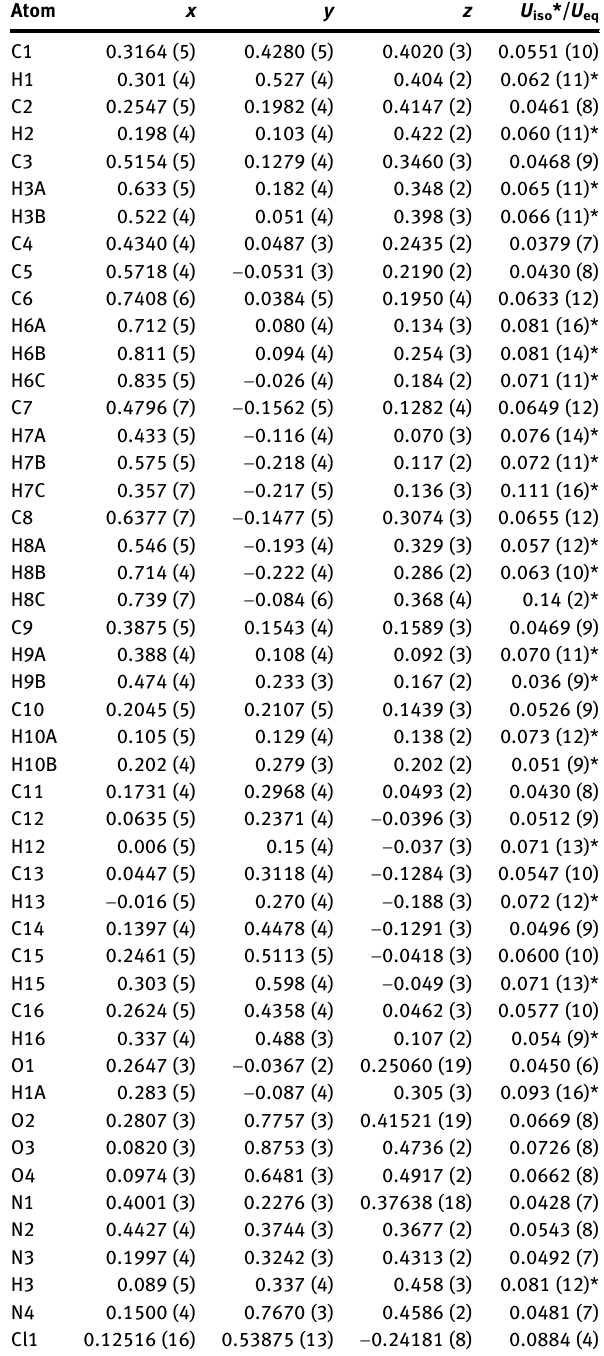
Table  : Fractional atomic coordinates and isotropic or equivalent isotropic displacement parameters (Å 